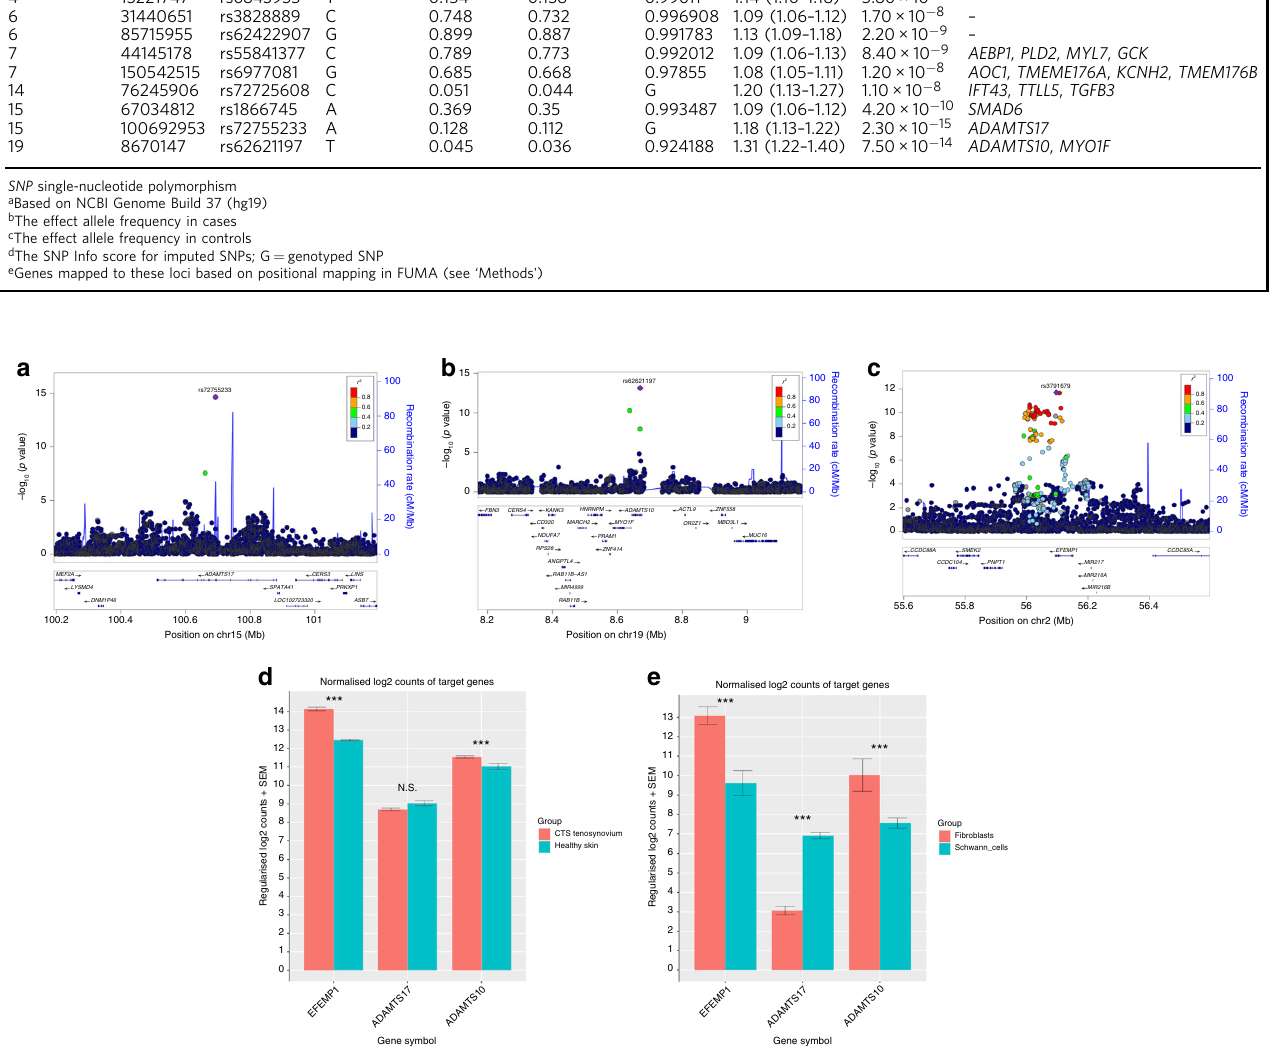
Fig. 2 Regional association plots for three GWAS loci and the expression of target genes from RNA-Seq. a Chromosome 15q26.3 (the site of missense variant in ADAMTS17 ). b Chromosome 19p13.2 (the site of missense variant in ADAMTS10 ). c Chromosome 2p16.1 (the site of intronic variant in EFEMP1 ). SNP position is shown on the x -axis, and the strength of association on the y -axis. The linkage disequilibrium (LD) relationship between the lead SNP and the surrounding SNPs is indicated by the colour. In the lower panel of each fi gure, genes within 500 kb of the index SNP are shown. The position on each chromosome is shown in relation to Human Genome build hg19. d Comparison of gene expression between tenosynovium of 41 CTS cases and the index fi nger skin of six healthy individuals. e Comparison of gene expression between human cultured fi broblasts and Schwann cells from Weiss et al. 38 . Error bars represent the standard error of the mean of the regularised log2 counts. p Value was determined using Wald test and was FDR adjusted. *** p Value< 0.01; NS = not signi fi cant. Source data are provided as a Source Data fi le. CTS, carpal tunnel syndrome; FDR, false discovery rate; GWAS, genome-wide association study; RNA-Seq, RNA sequencing; SNP, single-nucleotide